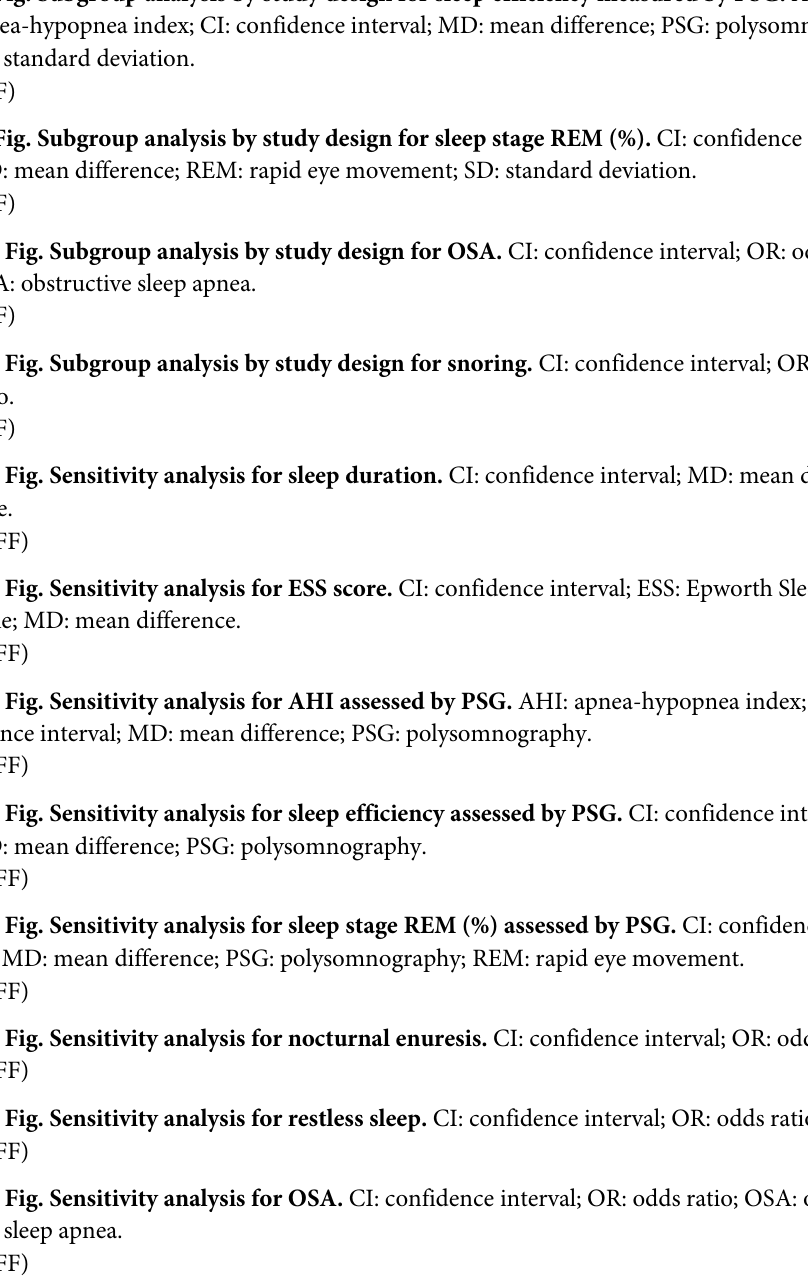
S6 Fig. Subgroup analysis by study design for sleep duration. CI: confidence interval; MD: mean difference; SD: standard deviation. (TIF) S7 Fig. Subgroup analysis by study design for AHI. AHI: apnea-hypopnea index; CI: confi- dence interval; MD: mean difference; SD: standard deviation. (TIF) S8 Fig. Subgroup analysis by study design for sleep efficiency measured by PSG. AHI: apnea-hypopnea index; CI: confidence interval; MD: mean difference; PSG: polysomnography; SD: standard deviation. (TIF) S9 Fig. Subgroup analysis by study design for sleep stage REM (%). CI: confidence interval; MD: mean difference; REM: rapid eye movement; SD: standard deviation. (TIF) S10 Fig. Subgroup analysis by study design for OSA. CI: confidence interval; OR: odds ratio; OSA: obstructive sleep apnea. (TIF) S11 Fig. Subgroup analysis by study design for snoring. CI: confidence interval; OR: odds ratio. (TIF) S12 Fig. Sensitivity analysis for sleep duration. CI: confidence interval; MD: mean differ- ence. (TIFF) S13 Fig. Sensitivity analysis for ESS score. CI: confidence interval; ESS: Epworth Sleepiness Scale; MD: mean difference. (TIFF) S14 Fig. Sensitivity analysis for AHI assessed by PSG. AHI: apnea-hypopnea index; CI: con- fidence interval; MD: mean difference; PSG: polysomnography. (TIFF) S15 Fig. Sensitivity analysis for sleep efficiency assessed by PSG. CI: confidence interval; MD: mean difference; PSG: polysomnography. (TIFF) S16 Fig. Sensitivity analysis for sleep stage REM (%) assessed by PSG. CI: confidence inter- val; MD: mean difference; PSG: polysomnography; REM: rapid eye movement. (TIFF) S17 Fig. Sensitivity analysis for nocturnal enuresis. CI: confidence interval; OR: odds ratio. (TIFF) S18 Fig. Sensitivity analysis for restless sleep. CI: confidence interval; OR: odds ratio. (TIFF) S19 Fig. Sensitivity analysis for OSA. CI: confidence interval; OR: odds ratio; OSA: obstruc- tive sleep apnea.